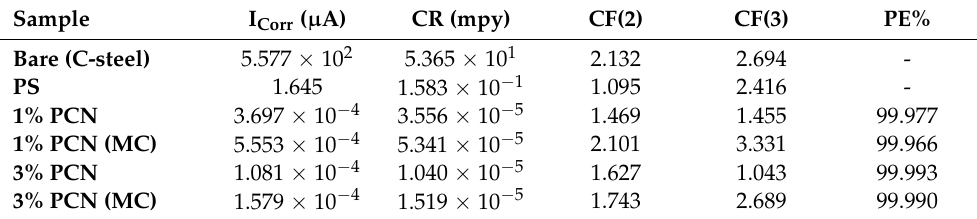
Table 4. The EFM results of bare C-steel, PS, 1% PCN, 3% PCN, 1% PCN (MC) and 3% PCN